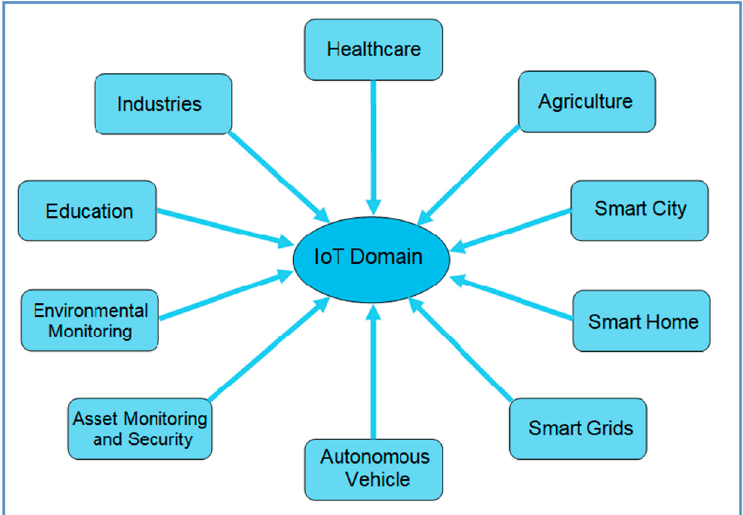
Figure 1. Representation of the IoT domains.